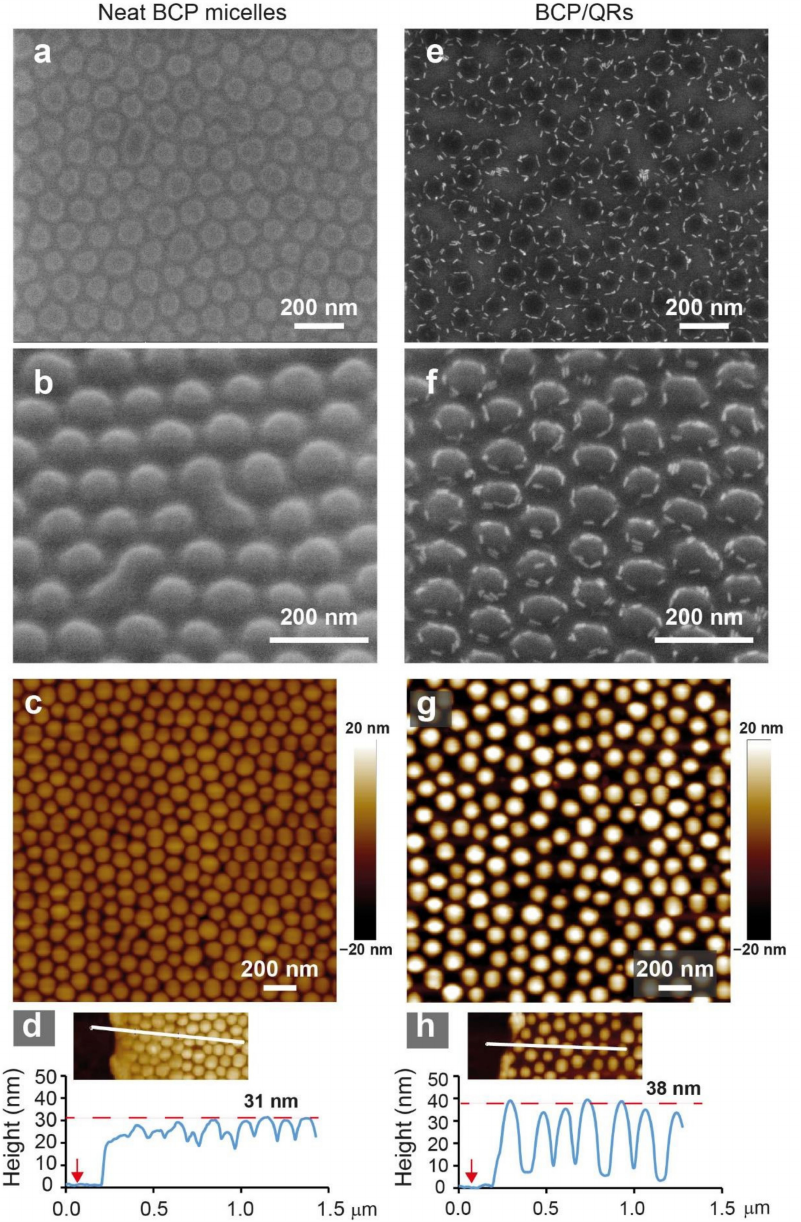
Figure 1. Top view ( a , e ) and tilted ( b , f ) SEM images and AFM images ( c , g ) of micellar PS 89 - b -P2VP 181 films cast from 0.5 wt.% toluene solutions and annealed in toluene vapor. ( a – c ) Neat BCP films. ( e – g ) BCP films containing CdS QRs (surface fraction σ QR = 0.08). ( d , h ) AFM height cross-sections made near a scratch in the film corresponding to the images shown in panels ( c , g ); red arrows denote the bare substrate